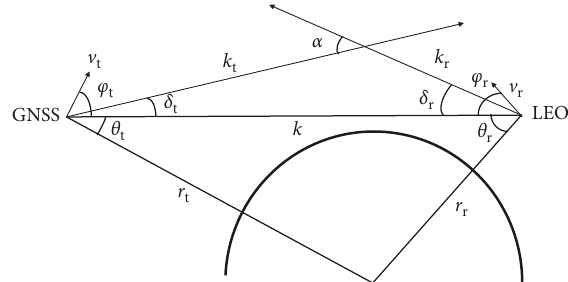
Figure 2: Schematic diagram for inversion of atmospheric bending angle using geometrical